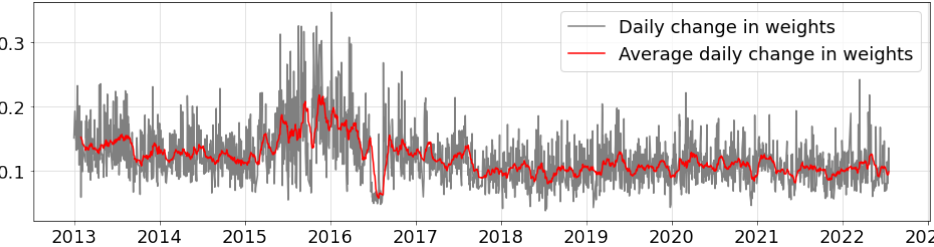
Figure 7. The daily ratio of shared to be re-weighted in the heuristic max-reward 1000 portfolio, taking into consideration both buy and sell orders. The average daily change in weight denoted with the red line is calculated as a rolling window average of the past 20 days’ changes in